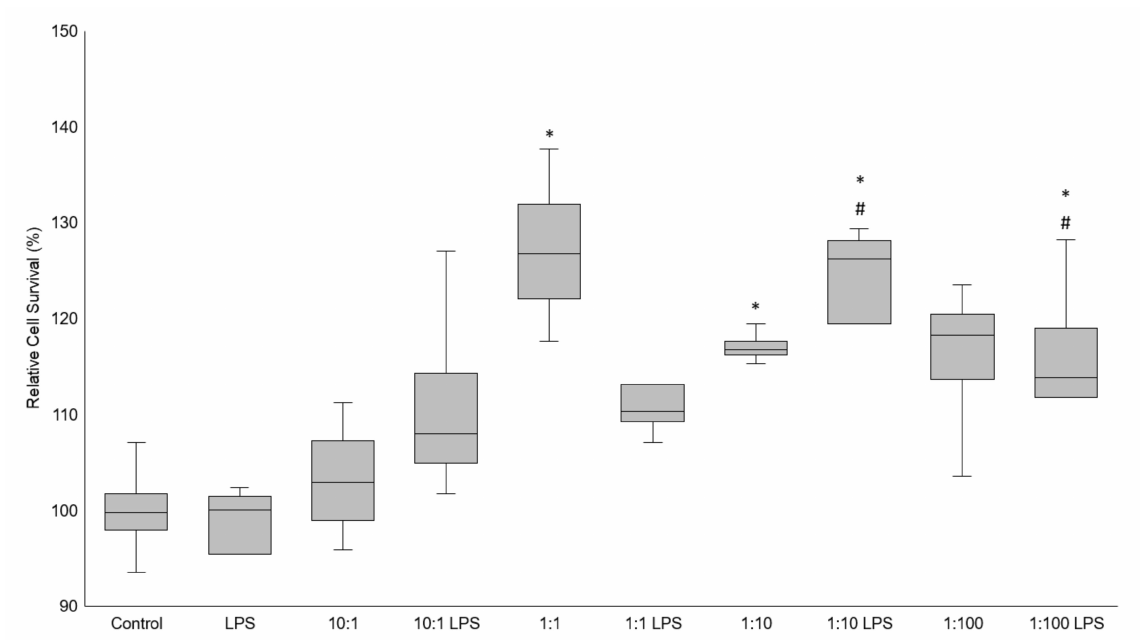
Figure 1. MTT results expressed as the relative cell survival. Caco-2 cells were challenged using four different cell/colony-forming unit (CFU) ratios (i.e., 10:1, 1:1, 1:10, and 1:100) for 24 h, in the absence of or in combination with an inflammatory stimulus (i.e., LPS at a 1 µ g/mL concentration) added 4 h after probiotic exposure. Statistical analysis: one-way ANOVA followed by Dunnett’s post hoc. * p -value < 0.05 with respect to the untreated control. # p < 0.05 with respect to the LPS-treated